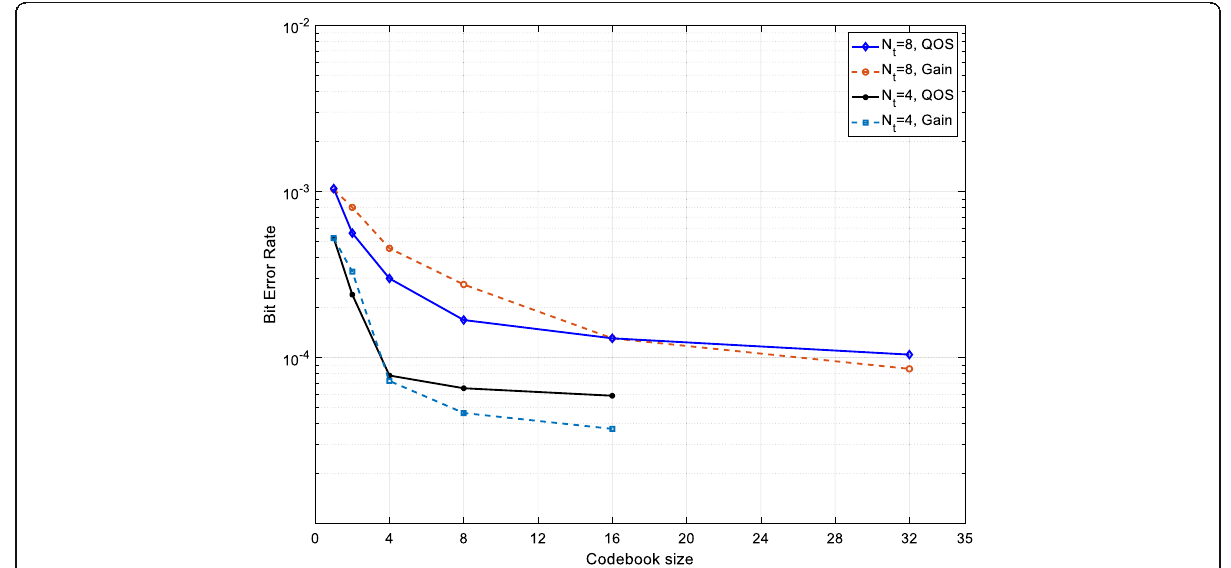
Fig. 3 Effect of gain and phase codebooks sizes for SM with N t = 4 and 8 and N r = 2. SNR = 20 dB